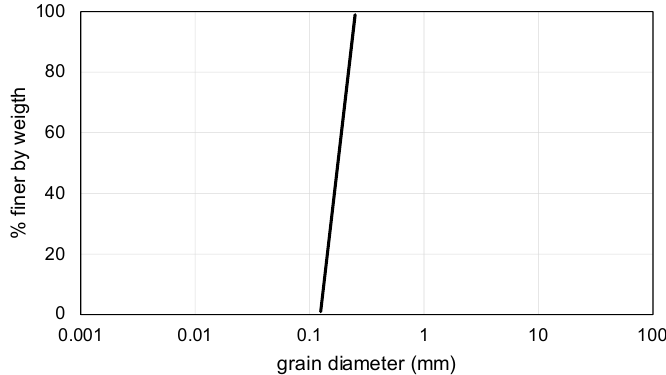
Figure 3. Grain size distribution curve of tested kinetic sand.